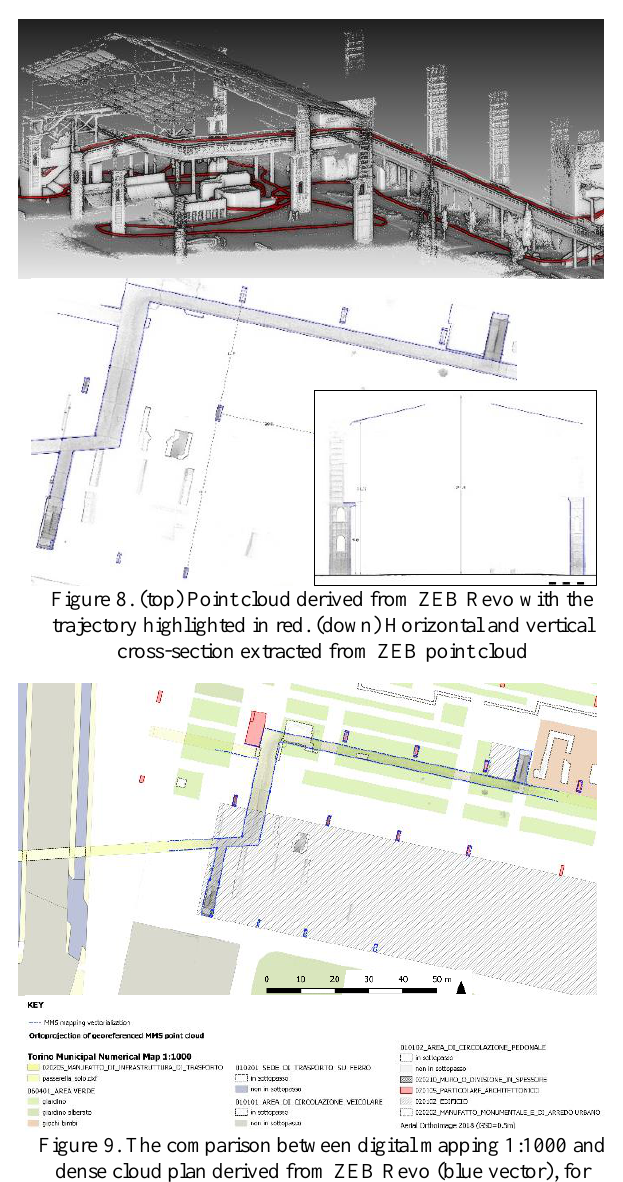
digital map 1:1000 in figure 9, demonstrates capabilities for mapping updating 1:500-1:200 scale up to an increased building